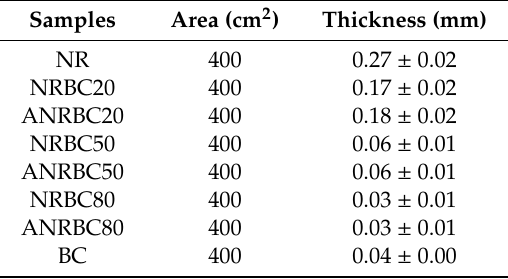
Table 1. Area and thickness of